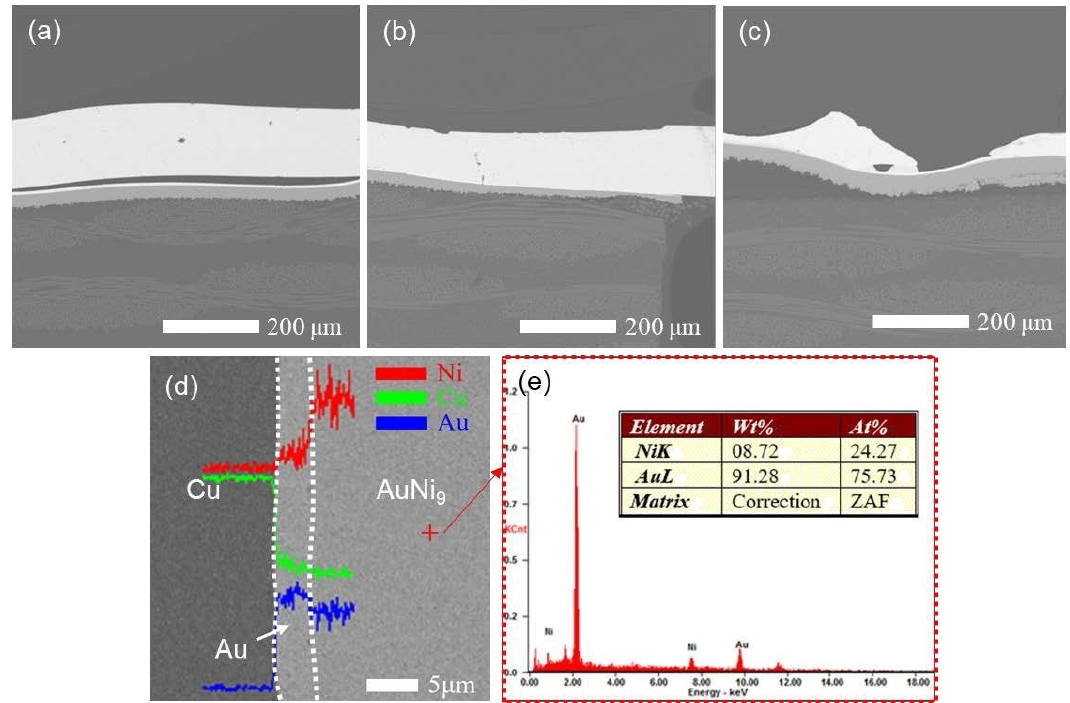
Figure 6. Cross-sectional SEM images of welding interface between AuNi 9 microwire and Au microlayer at ( a ) 0.200 kA, 3 ms, and 9.8 N; ( b ) 0.275 kA, 3ms, and 28.7 N; and ( c ) 0.275 kA, 6 ms, and 9.8 N. ( d ) Elemental line scan of the welding interface at the optimized parameters. ( e ) Element composition of the microwire. The parameters correspond with designations a, m, and d in Table 1, respectively.